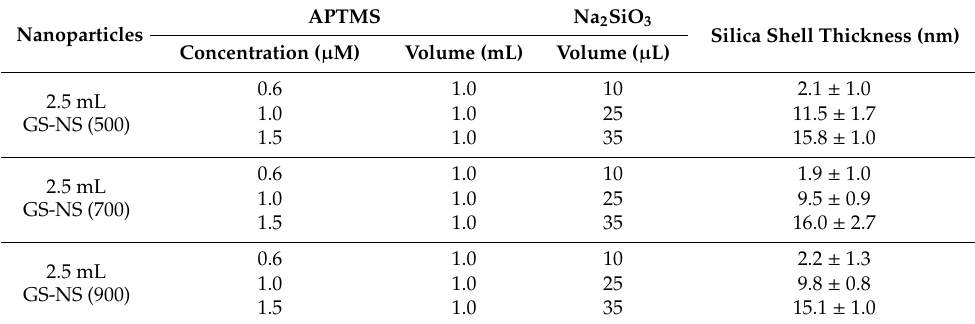
Table 1. Concentration and volume of colloidal GS-NS suspension and silica precursors used to obtain silica shells of varying thicknesses.